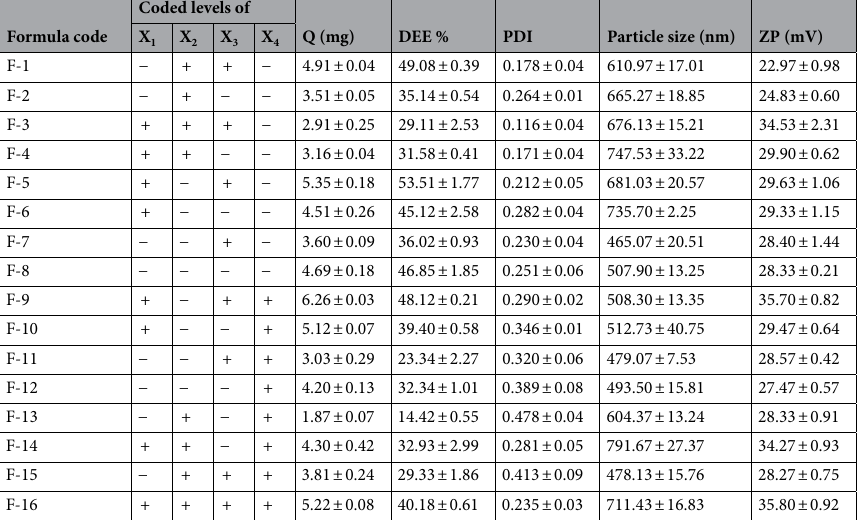
Table 2. Formulations and properties of ALL-loaded CS/STPP NPs prepared according to 2 4 full factorial design. Each value represents the mean ± SD (n = 3). X 1 , X 2 , X 3 , X 4 are CS concentration, STPP concentration, CS:STPP volume ratio and ALL amount,